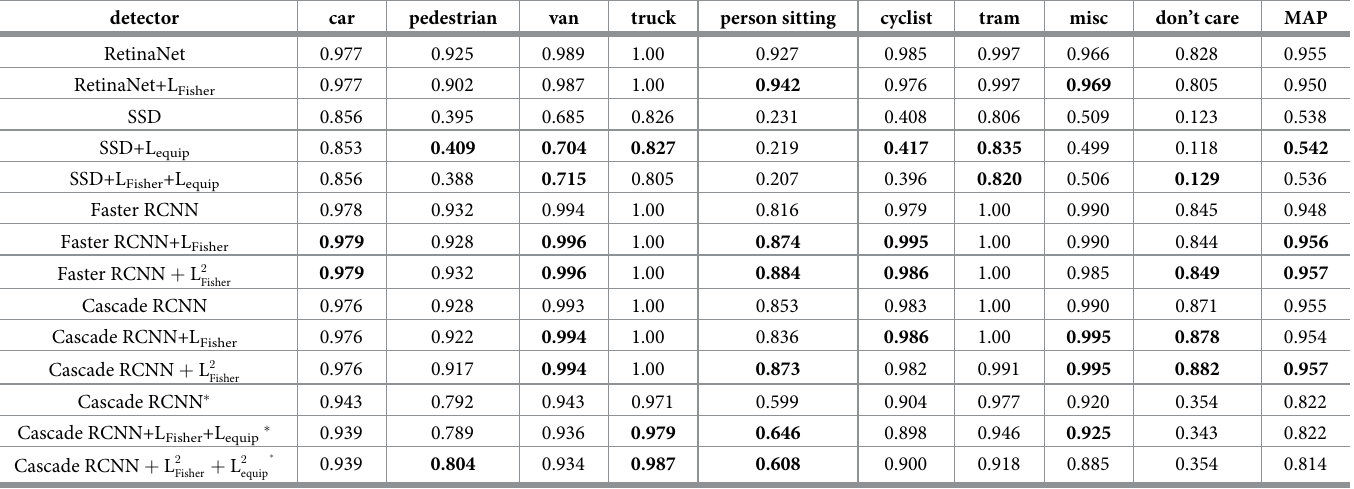
Table 2. Ablation evaluations of structural constraint mechanism on KITTI . detector